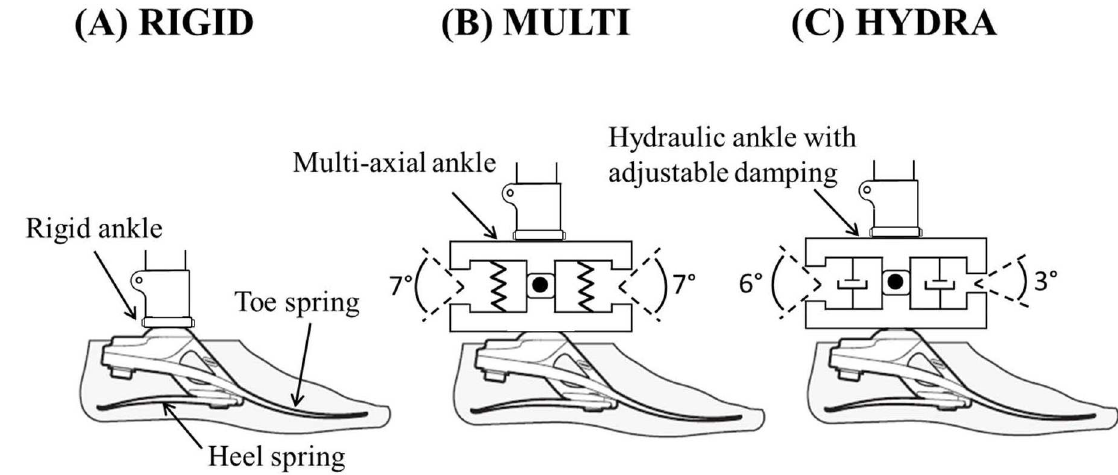
Fig 2. Schematic drawings of the: (A) Endolite Esprit ankle-foot system(RIGID) with a dynamic-response foot (i.e., carbon toe and heel spring as shown in manufacturer’s specifications) and rigid ankle, (B) Endolite Epirus ankle-foot system(MULTI) with a dynamic-response foot and multi-axial ankle, and (C) Endolite Echelon ankle-foot system (HYDRA) with a dynamic-response foot and hydraulic ankle with adjustable damping.